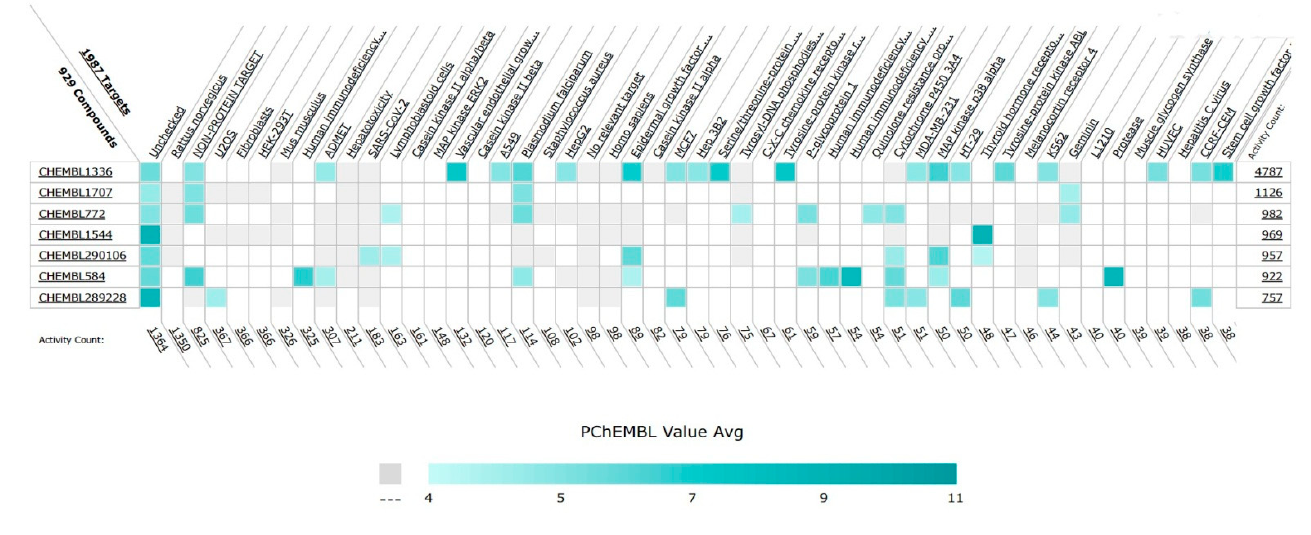
Figure 2. Correlation of nitrogen containing heterocyclic compounds violating RO5 with biological activities.